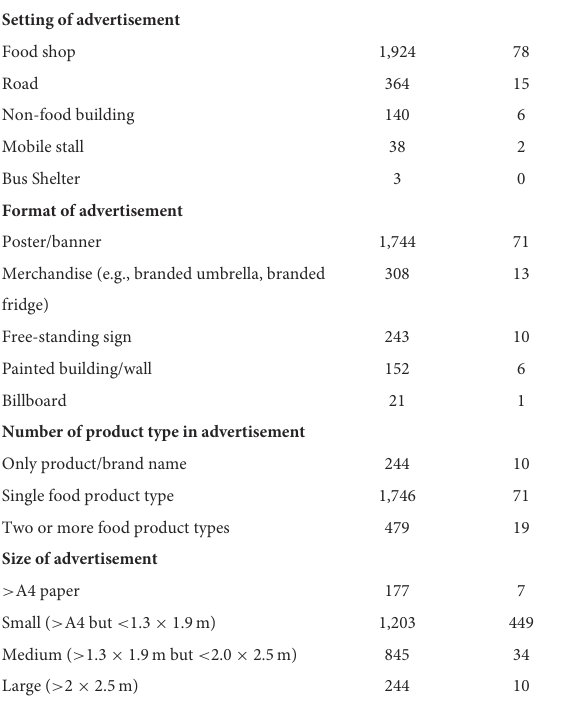
TABLE 2 Characteristics of food advertisements in/around schools in Greater